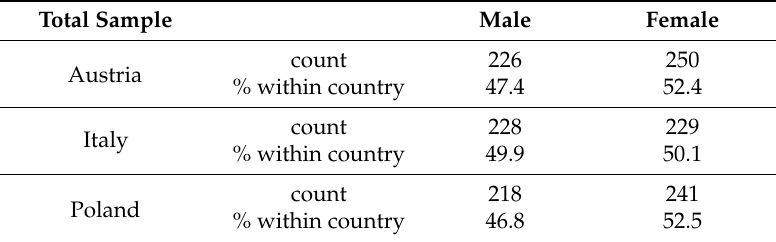
Table 2. Description of the country sub-samples (gender).